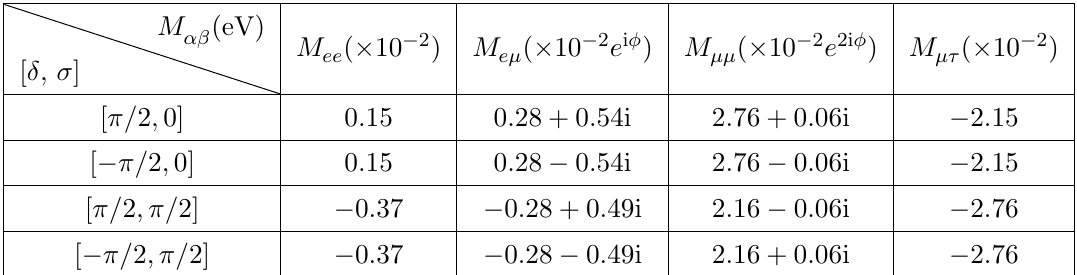
Table 1 . The possible values of M